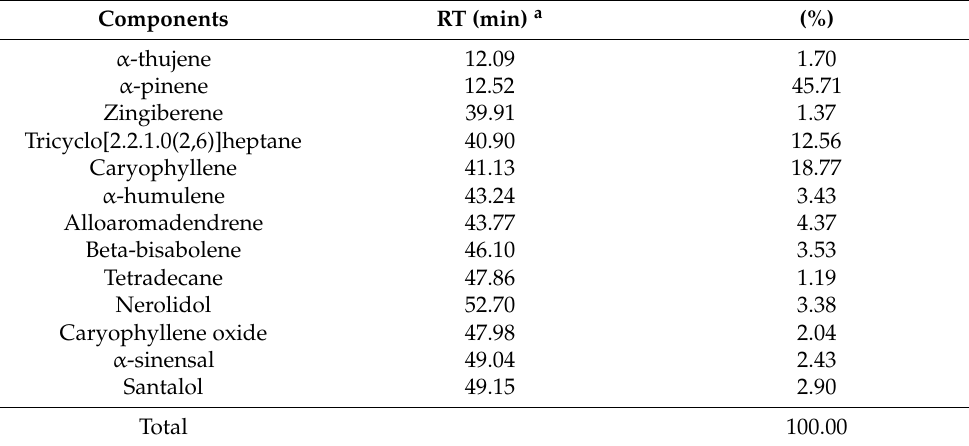
Table 1. Chemical composition (%) of the essential oil of C. verbenacea .